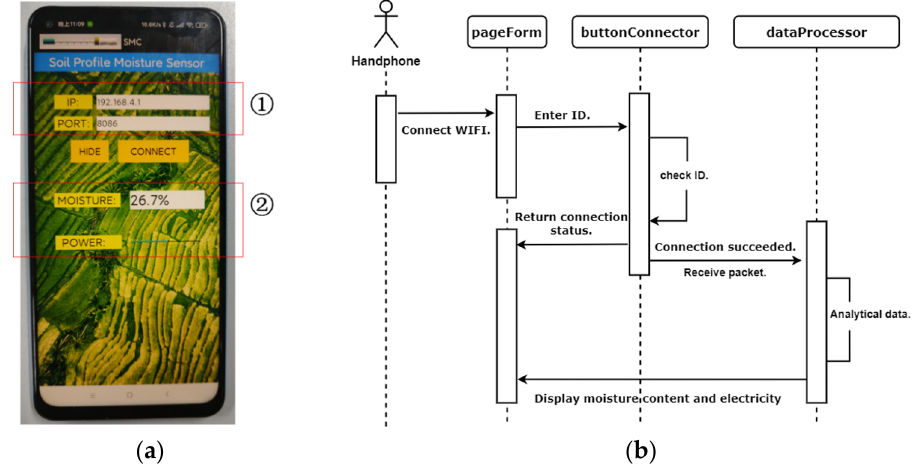
Figure 10. Smartphone app of sensor. ( a ) Interface diagram; ( b ) timing diagram. ① Sensor identification; ② measurement results.